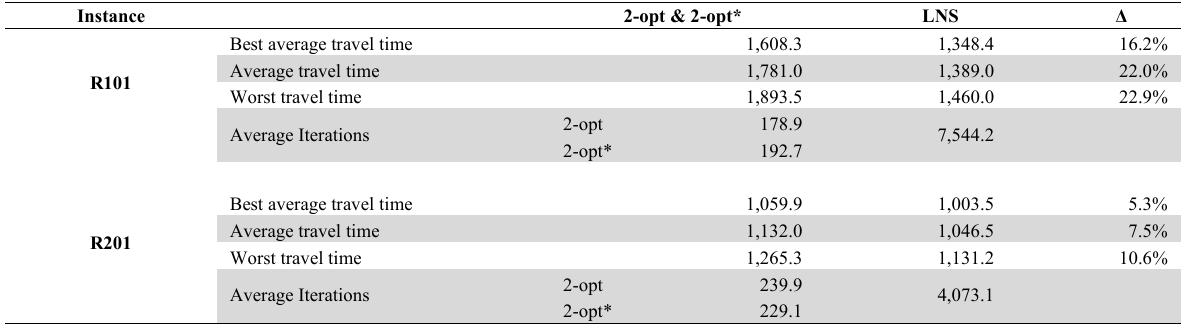
Results of executing travel time minimisation procedure with different local search procedures at execution time 0.5